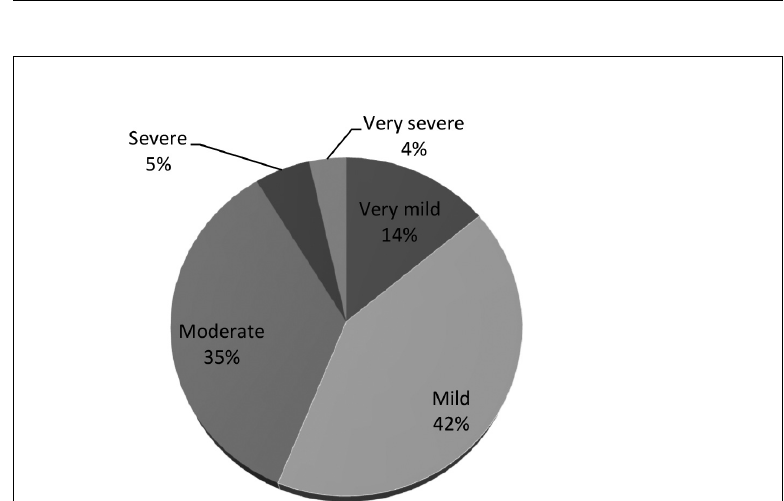
Note. Ant. – anterior, post. – posterior.